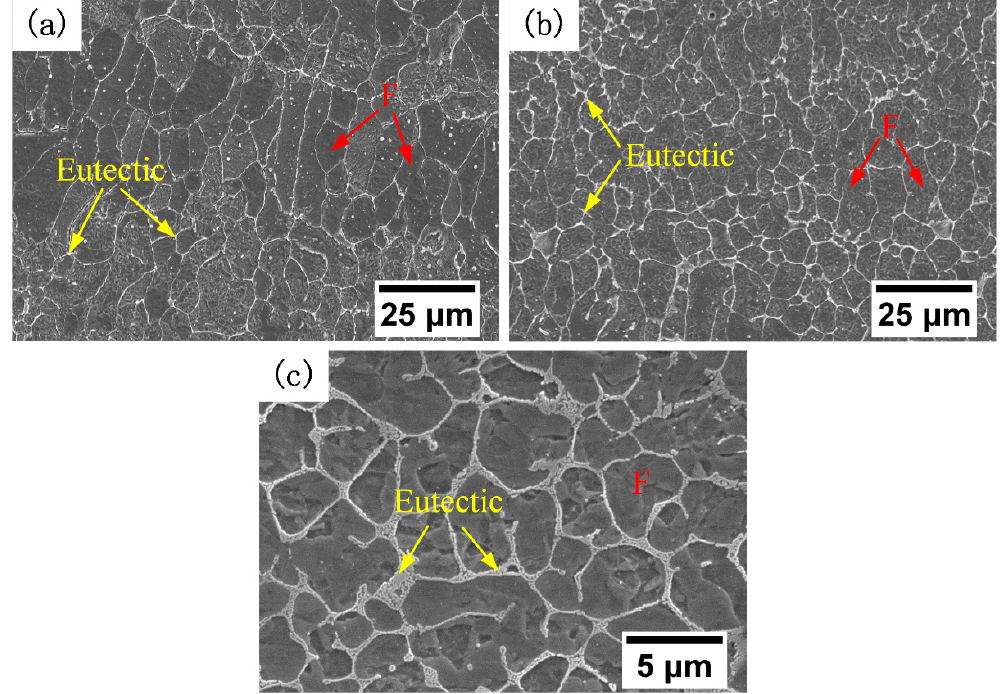
Figure 6. SEM micrographs of the deposited alloys at different concentrations of Fe–Cr–B–Si–Mo powder: ( a ) 6.25%, ( b ) 12.5%, and ( c ) 25%, respectively.